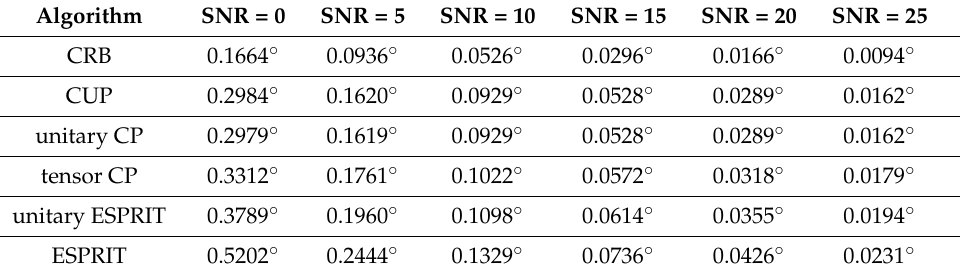
Figure 7. RMSE of range estimation versus SNR. Table 3. RSME of angle estimation versus SNR.